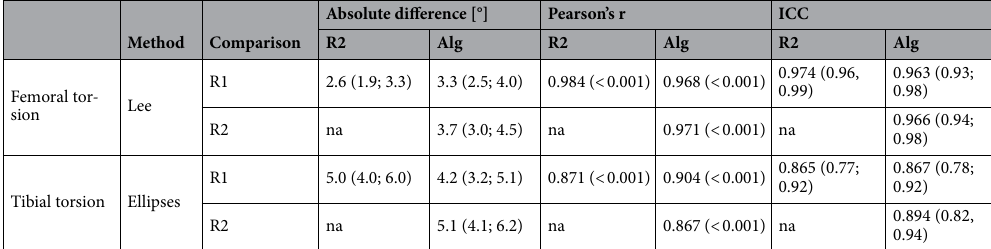
Table 2. Metrics of inter-reader difference and agreement for femoral and tibial torsion as determined by the Lee and ellipses methods. Readers were the two radiologists (radiologist 1 [R1], radiologist 2 [R2]) and the algorithm (Alg). In a pair-wise manner, absolute differences [°] and agreement were quantified in terms of Pearson’s correlation coefficient r and the intraclass-correlation-coefficient (ICC, single scorings [not adjusted]). Means (95% confidence intervals). na – not applicable. Results of the other methods of determining femoral (according to the Reikeras, Tomczak, and Murphy methods) and tibial torsion (according to the bimalleolar and talus methods) are detailed in Supplementary Table 3.